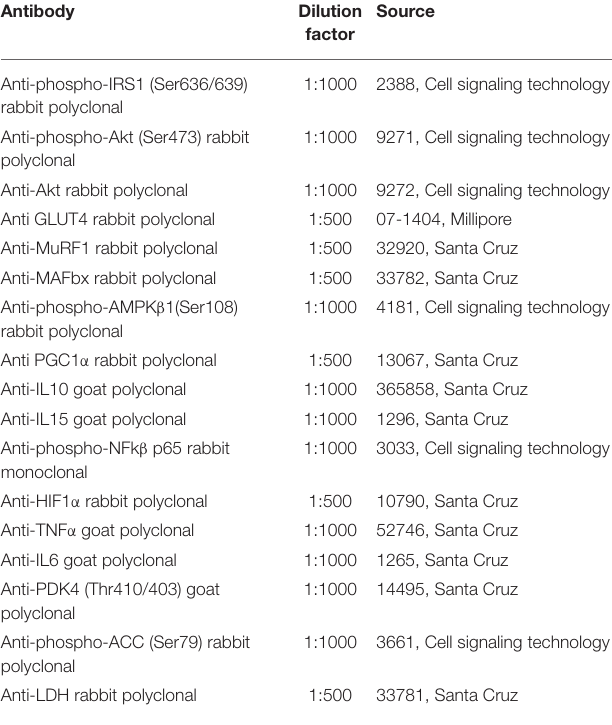
TABLE 1 | List of antibodies used.